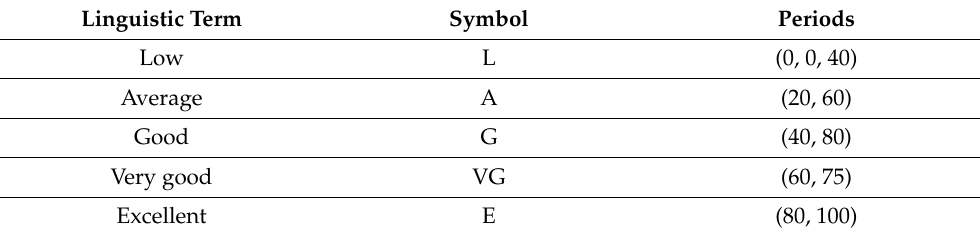
Table 6. Fuzzy set of the output of disabled student assessment.